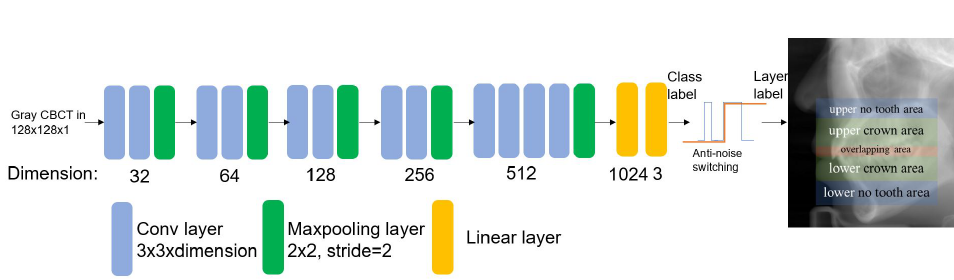
Figure 3. Pre-processing network structure. The input 128 × 128 × 1 gray image passes through our mini-VGG network and gets the class label, and an anti-noise switch determines its layer